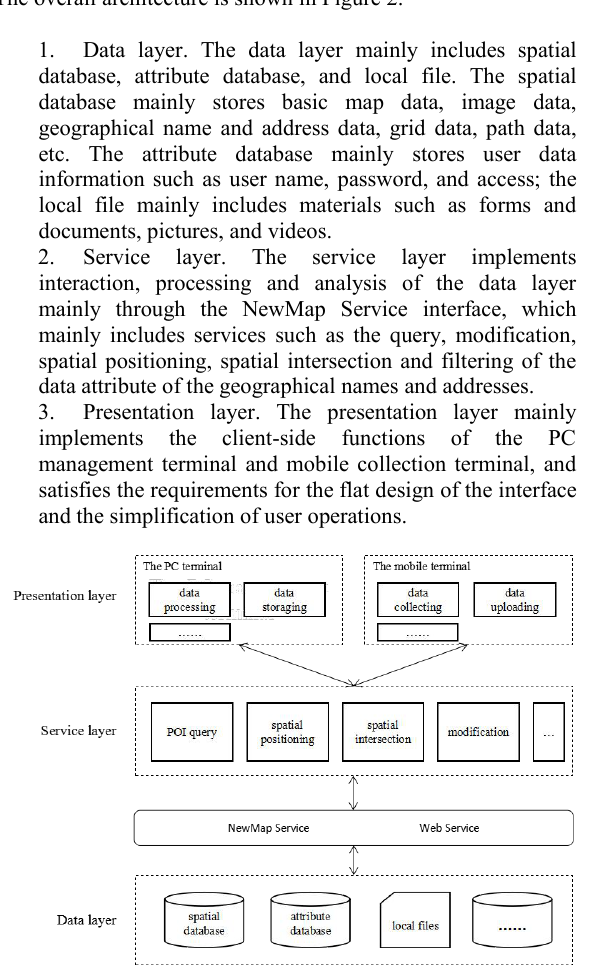
Figure 2. System